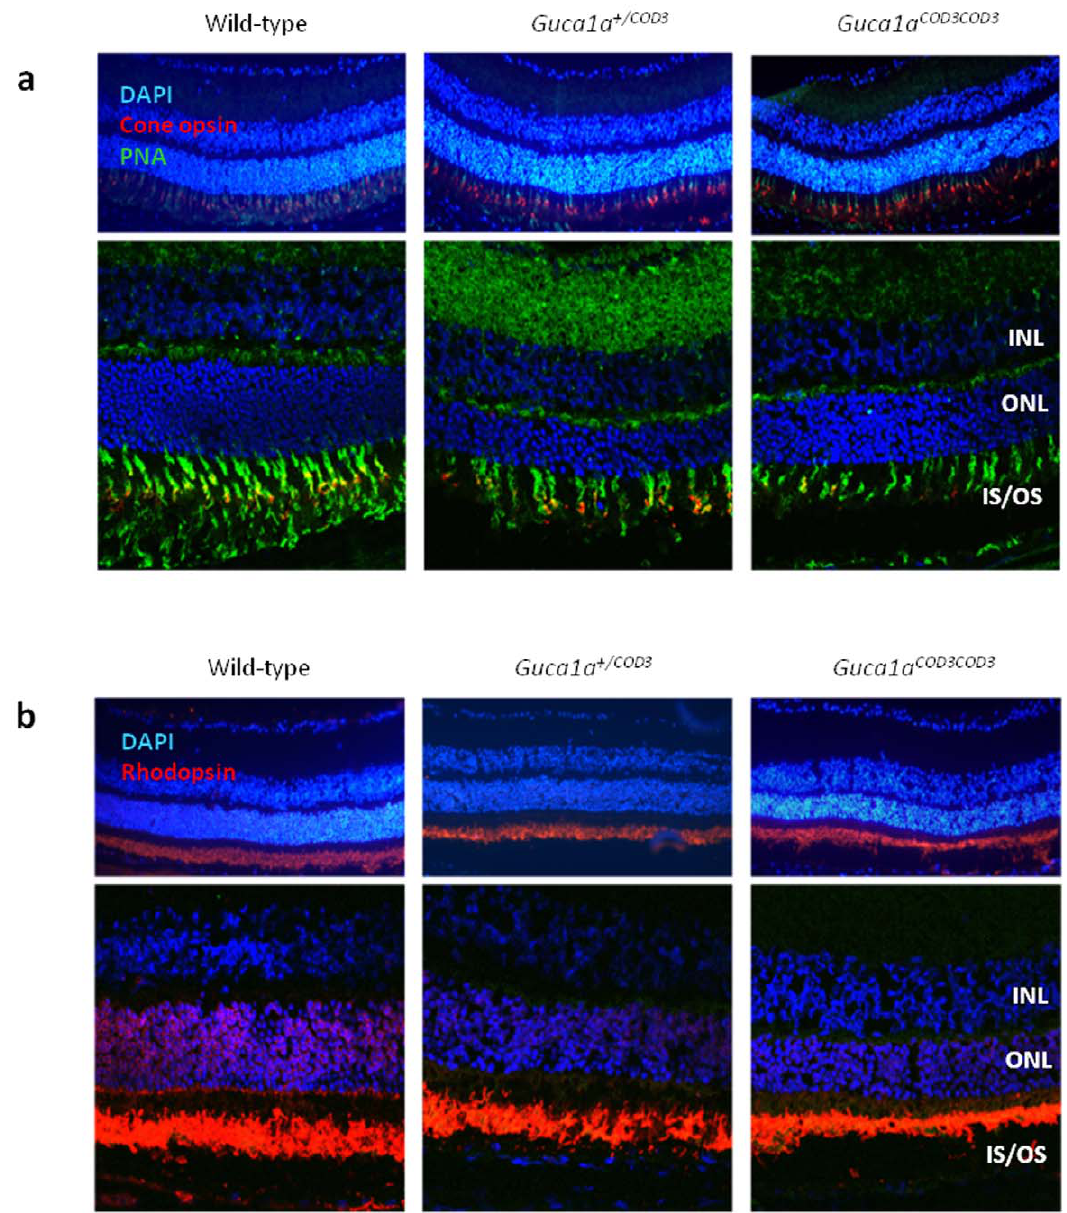
Figure 7. Photopigment expression in ‘ Guca1a COD3 ‘knock-in’ mice. Representative cryosections from five month-old mice stained with DAPI and ( a ) a combined anti-L/M- and S-cone opsin antibody (red) and PNA (green), and ( b ) an anti-rhodopsin (rod opsin) antibody (red). For both, upper panels show fluorescent light micrographs, and lower panels show single slices from confocal microscopy. The expression of both cone and rod opsin appears similar in both Guca1a + /COD3 and Guca1a COD3/COD3 mice compared with wild-type littermates, although the rod opsin staining indicates a shortening of rod outer segments. PNA staining (green) in ( a ) indicates a reduced number of cones in the mutant retinae which is more pronounced in homozygous than in heterozygous mutant mice. INL inner nuclear layer, ONL outer nuclear layer, IS/OS inner segment/outer